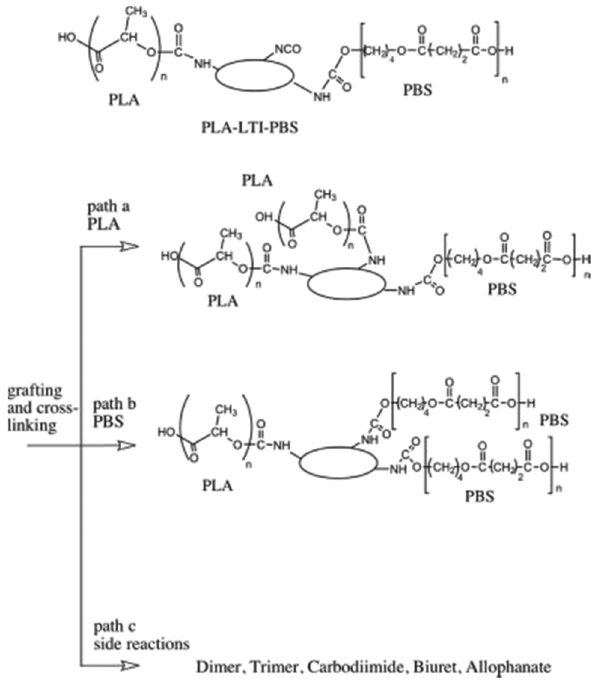
Figure 7: Predicted reaction pathways of PLA - LTI - PBS, PLA, and PBS ( 67 ) . Copyright 2007. Reproduced with permission from John Wiley and